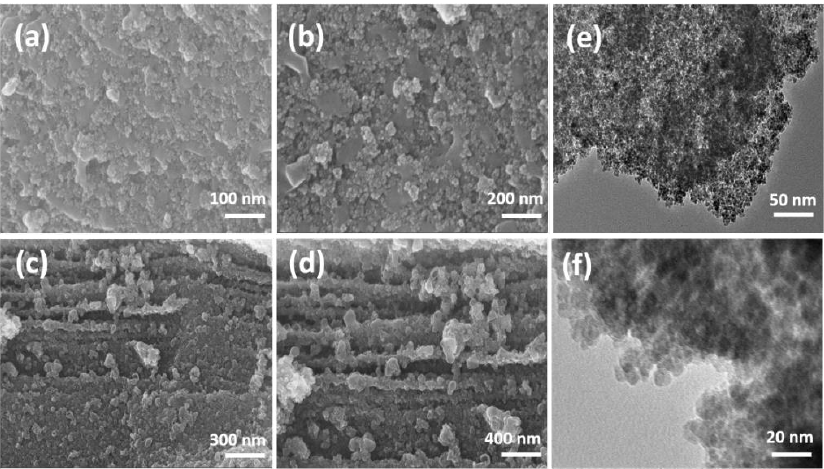
Figure 4. ( a – d ) SEM and ( e,f ) TEM images at different magnifications of Fe 3 O 4 /RGO composite.